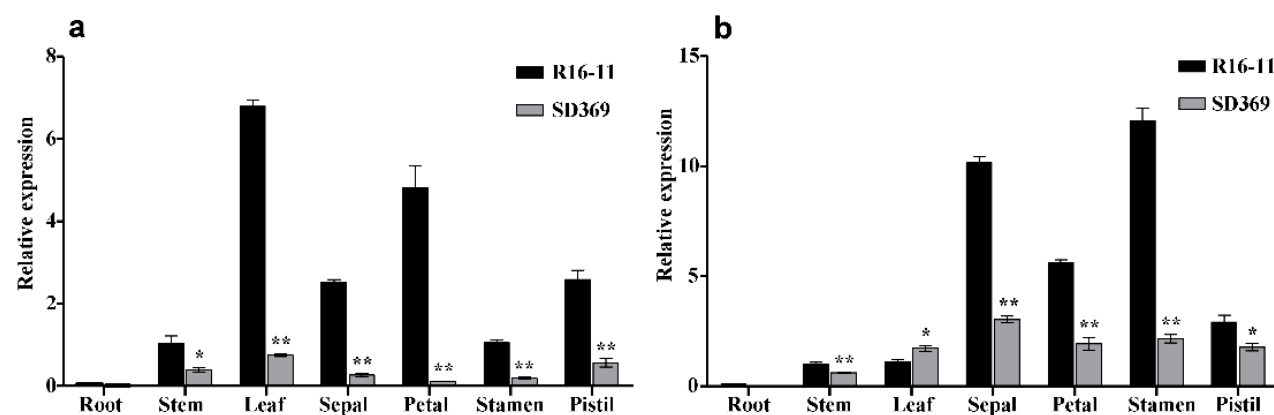
Figure 5. Gene expression data analysis. Quantitative RT-PCR of BrWAX3 ( BrCER60.A09 ) ( a ) and Bra004034 ( BrCER6.A07 ) ( b ) in different tissues of the two parents. The BrGAPDH was used as an internal control. Error bars indicate SE (n = 3). * p < 0.05. ** p < 0.01.